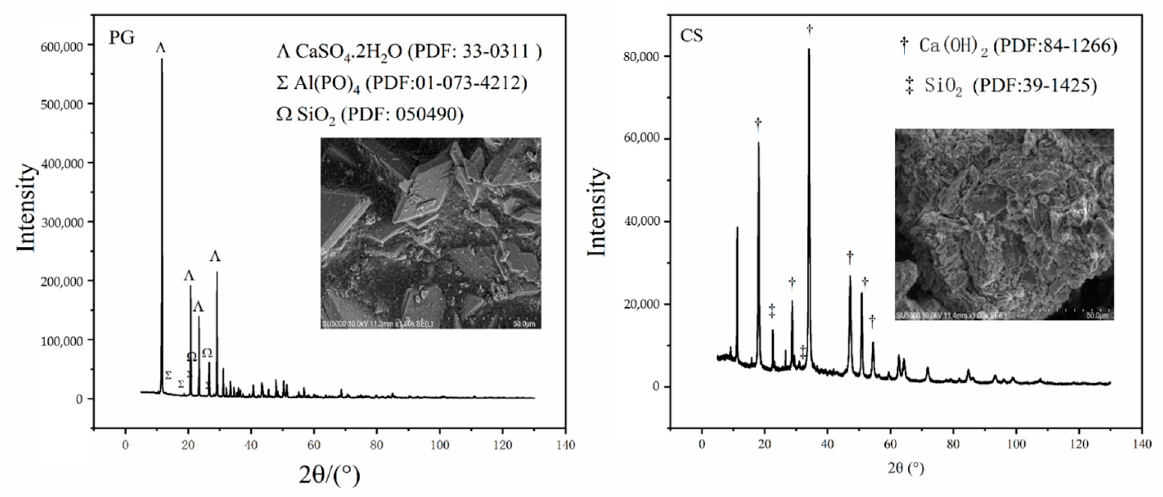
Figure 2. XRD of raw materials.